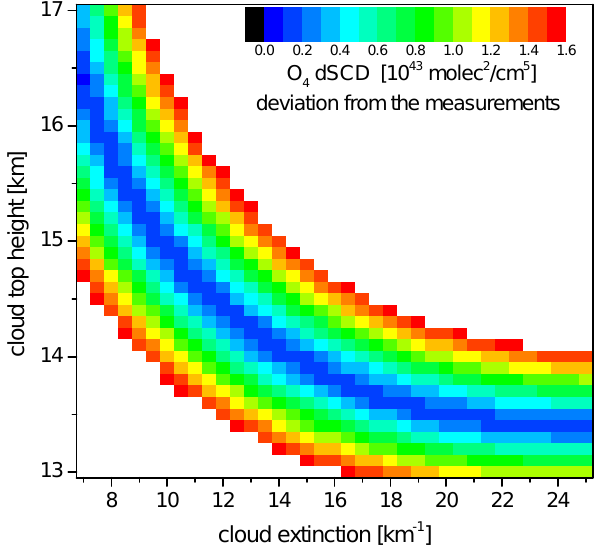
At flight altitude 948ppm (Fig. 2) corresponds to 0.19g wa- ter per m 3 . Because the water content is almost constant (Ta- 1160 ble 3), the cloud effective radius depends on the cloud ex- tinction k only, which is a function of the cloud top height (Fig. A2). Hence for each cloud top height a cloud effective radius can be given (Table A1). The variability in the cloud water ± 78ppm changes the cloud effective radius by 1.8 to 1165 3.5µm depending on the cloud extinction. Comparing the data on the cloud effective radius, there is a discrepancy between MODIS and CARIBIC. The effective radius based on the MODIS observation was 22 ± 6µm, this agrees with CARIBIC data only for the cloud top height of 1170 13.5 to 14.5km (Table A1). On the other hand the cloud top height according to MODIS was 120 to 105hPa i.e. 15 to 16km.Ofcourse,theeffectiveradiusisacriticalmeasurees- peciallyforiceclouds,asinEq.A1weassumetheicecrystal to be spherical, which is hardly ever the case. Measuring the 1175